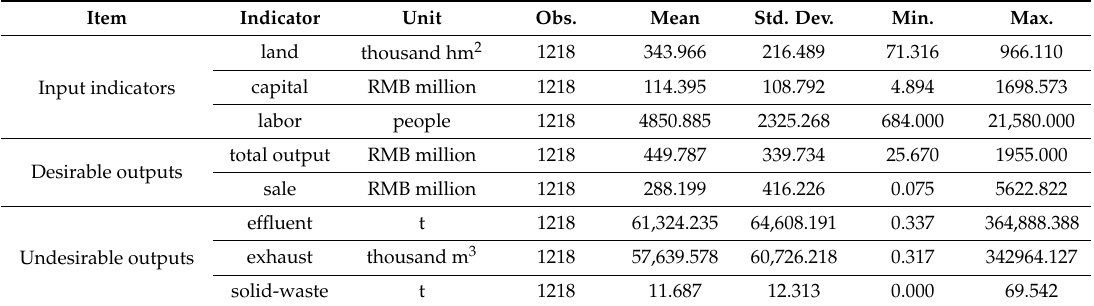
Table 2. Descriptive statistics of the input and output